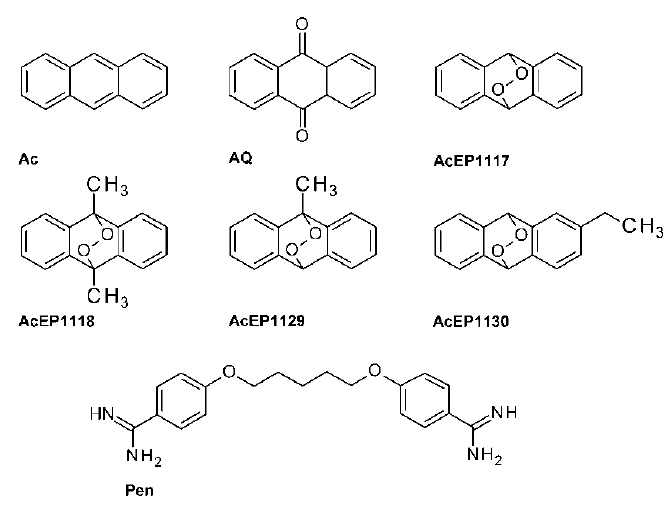
Figure 1. Structures of anthracene endoperoxides (AcEPs) and other compounds (Ac, anthracene; AQ, anthraquinone; Pen, pentamidine) used in this study.